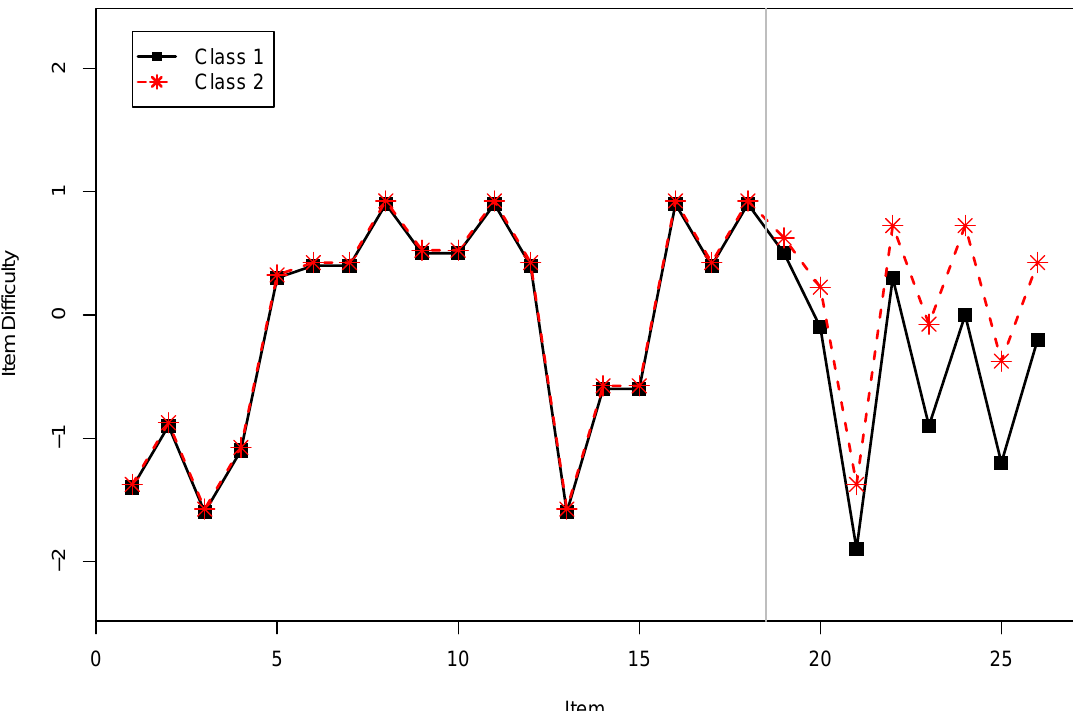
Figure 4. Simulated Case Study 2: True item difficulties b ic